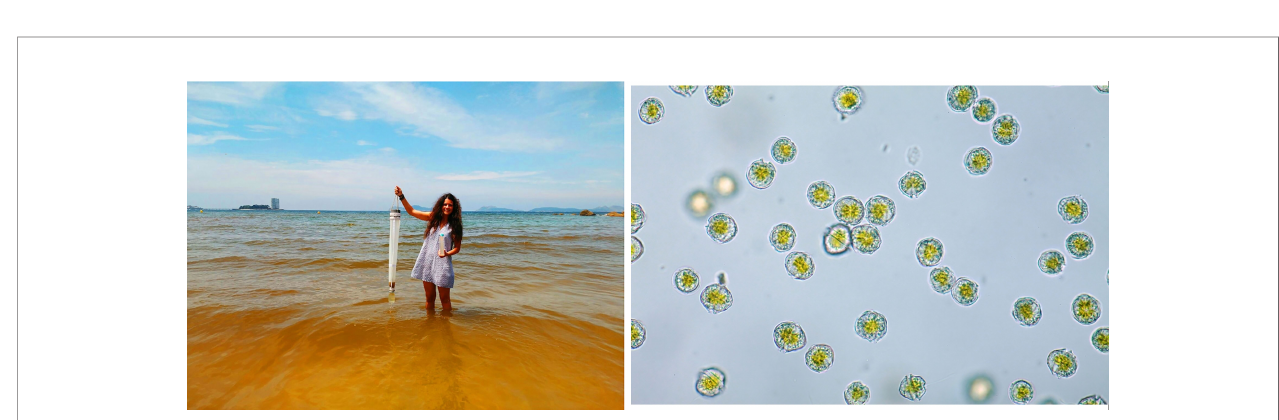
FIGURE 15 | PhD student Mar ı ́ a Garc ı ́ a-Portela (IEO Vigo) sampling the Alexandrium minutum red tide in Samil Beach, June 28 th , 2018. (left). A. minutum : light microscopy micrograph (400X) of the bloom sample from Samil Beach, June 28 th (right). Figure reproduced from Rodr ı ́ guez et al., 2018, Harmful Algae